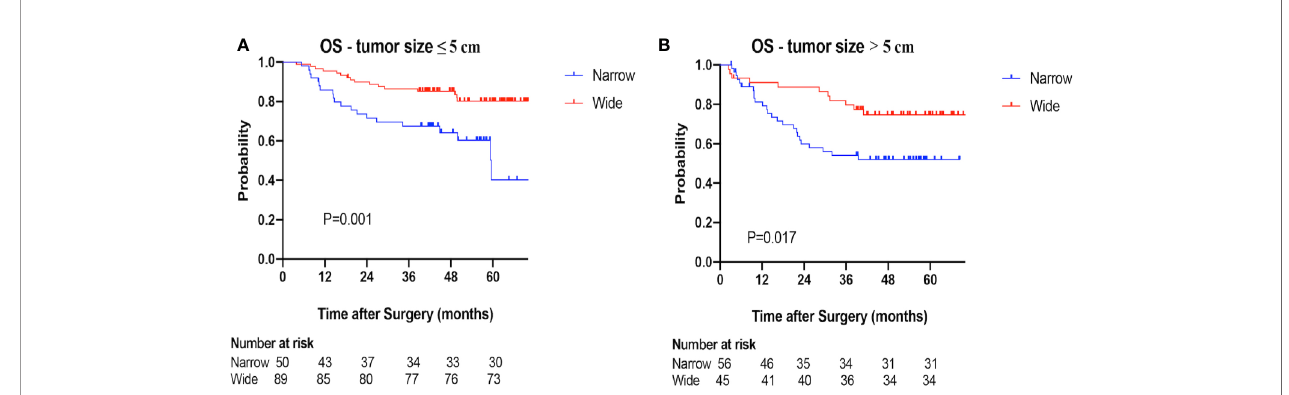
FIGURE 6 | Overall survival (OS) of the narrow-margin and wide-margin groups strati fi ed based on tumor size. (A) Overall survival in the subgroup of tumor size ≤ 5cm. (B) Overall survival in the subgroup of tumor